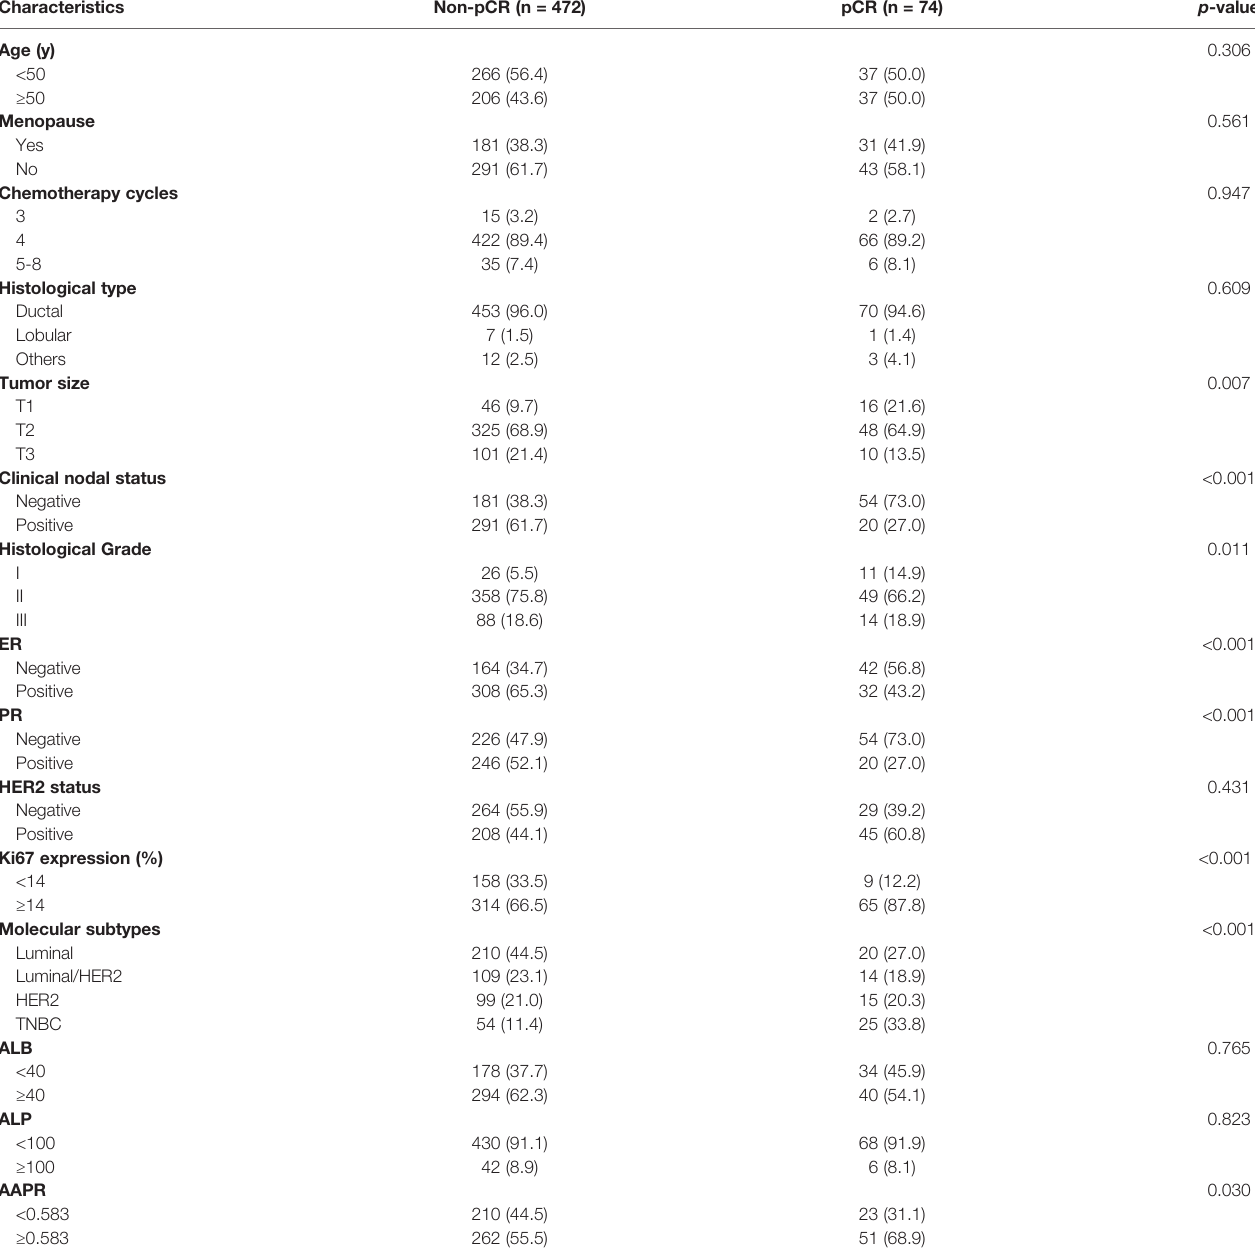
TABLE 3 | Univariate analysis for factors associated with pCR in the training cohort.